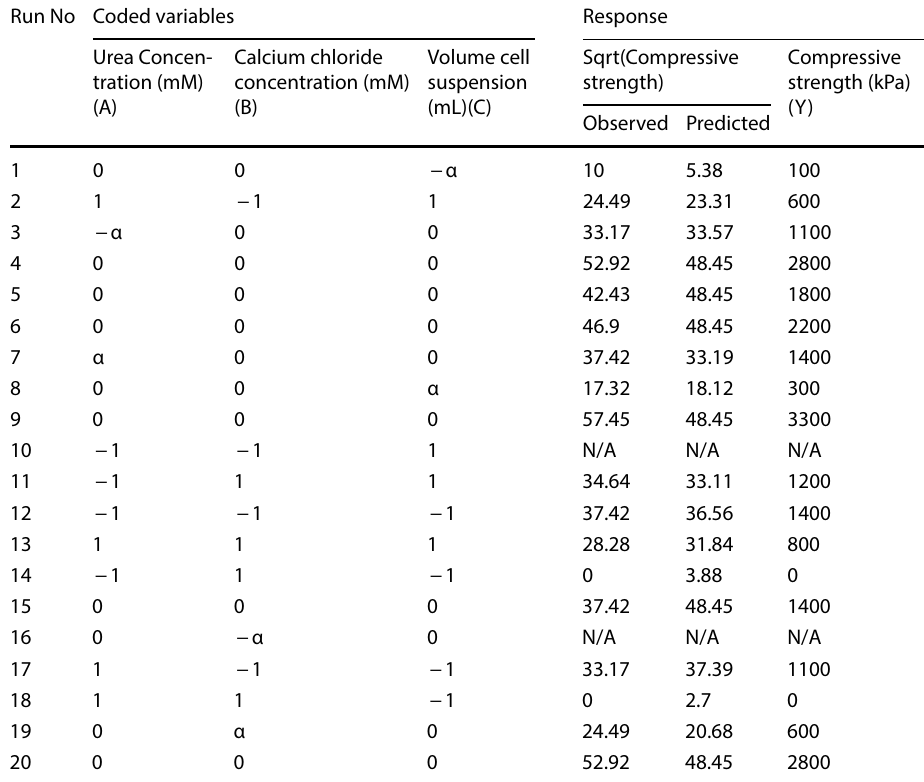
Table 3 Design matrix of the CCD used in this